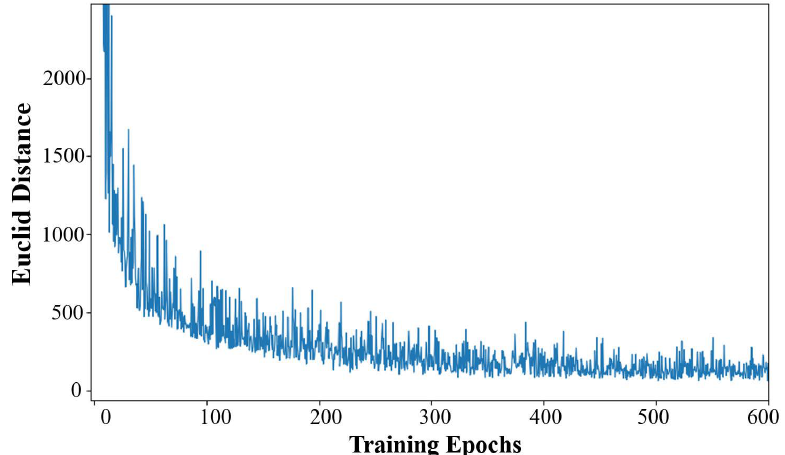
Figure 9. The convergence curve of the Euclid distance d Euc between the generated, complete power spectrum maps (PSMs) and the real, complete PSMs in the training